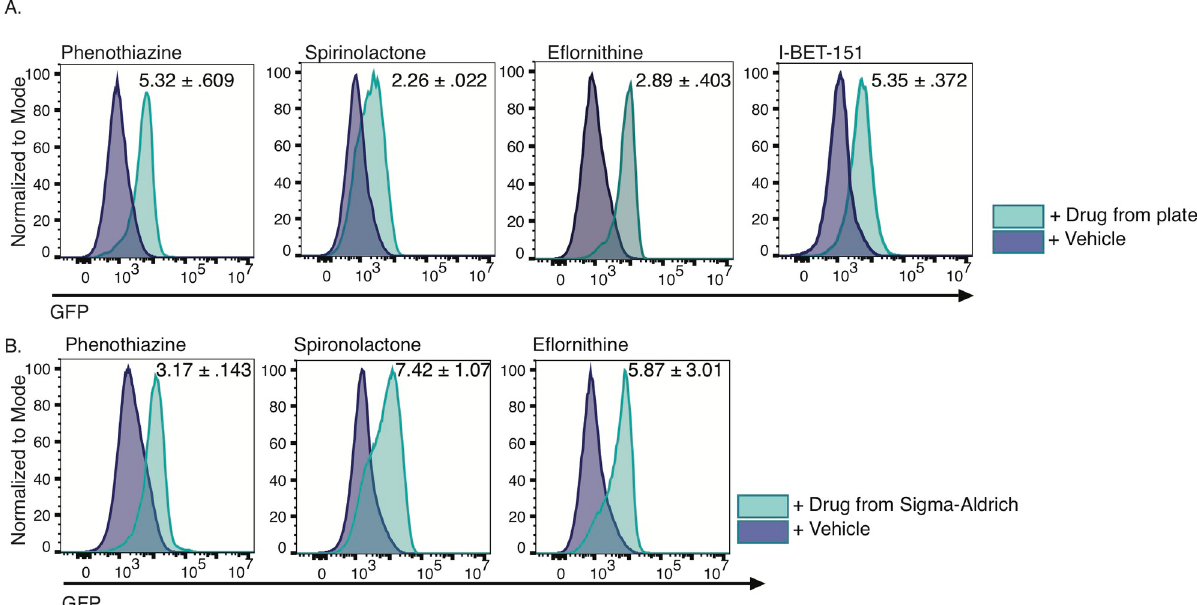
Fig 3. Three drugs from the small molecule library produced a reproducible shift in EP1/GFP expression. (A) Flow cytometry plots of GFP expression in EP1/GFP reporter parasites grown for 3 days in the presence of 33 μ M drug sourced from library plates or vehicle control. Inset indicates average fold change in median fluorescence intensity with standard deviation from 3 replicates of the experiment. (B) Flow cytometry plots of GFP expression in EP1/GFP reporter parasites grown for 3 days in the presence of fresh drug at 33 μ M sourced from Sigma-Aldrich. Inset indicates average fold change in median fluorescence intensity with standard deviation from 3 replicates of the